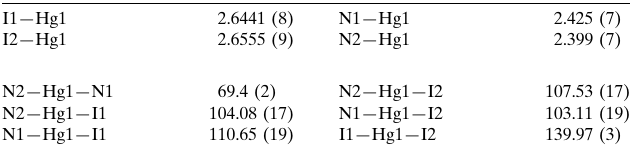
Selected geometric parameters (A˚ , (cid:1)